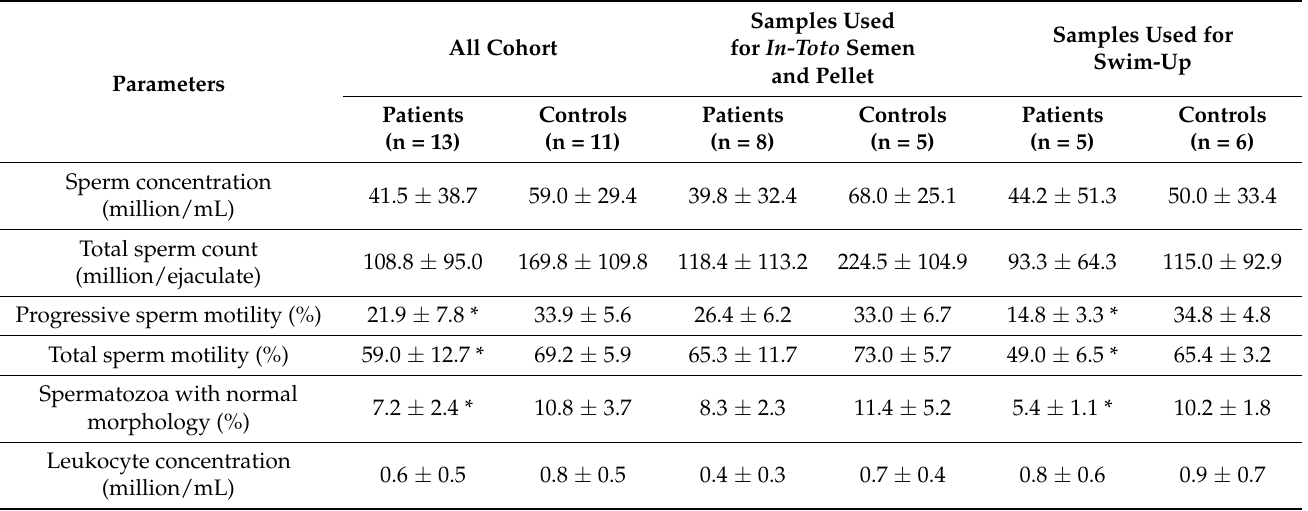
Table 2. Conventional sperm parameters of asthenozoospermic patients (patients) and normozoosper- mic men (controls) enrolled in this